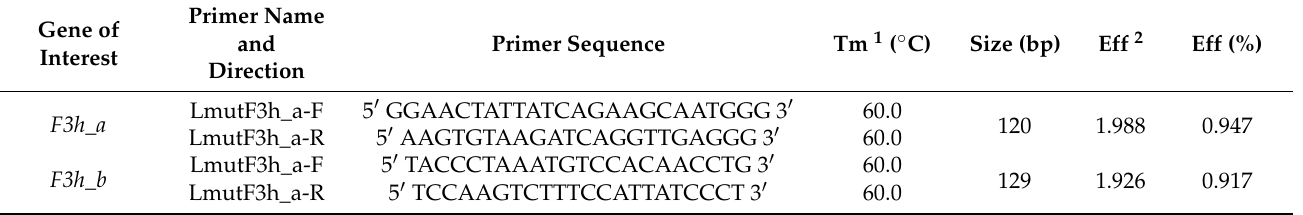
Table 2. Primers used for RT-qPCR analysis along seed coat development in white and brown seeds of Lupinus mutabilis